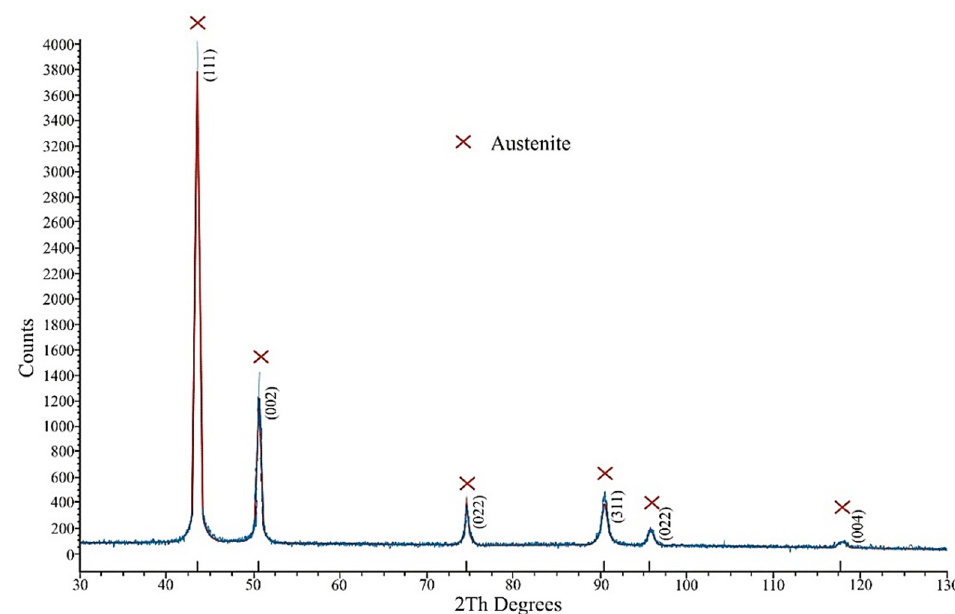
Figure 11. X-ray di ff raction patterns of sample 6 after Figure 11. X-ray diffraction patterns of sample 6 after SLM. Figure 11. X-ray diffraction patterns of sample 6 after SLM.